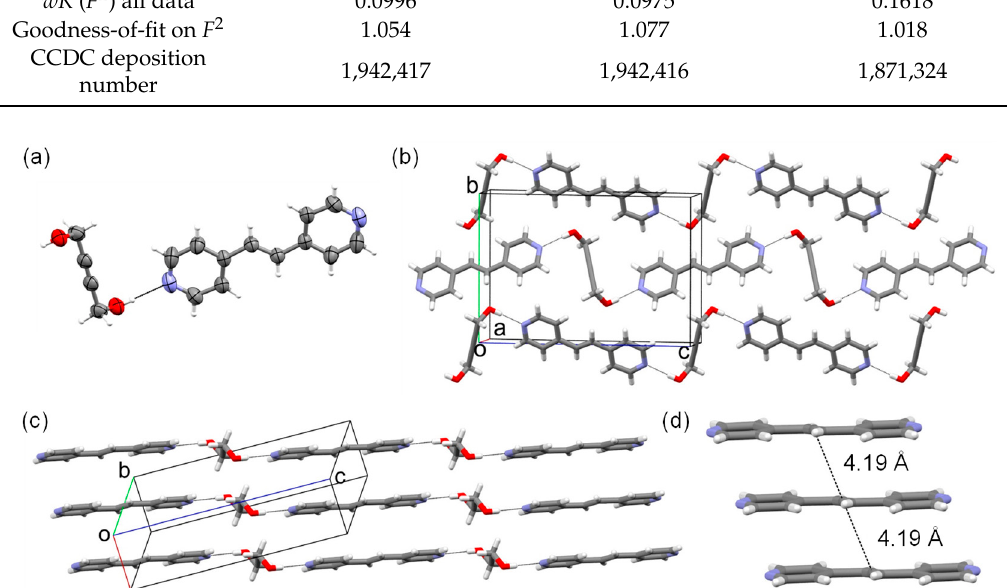
Figure 1. X-ray structure [( 1,4-bd )·( 4,4’-bpe )] n : ( a ) ORTEP representation, ( b ) 1D hydrogen-bonded chains, ( c ) stacks of hydrogen-bonded chains, ( d ) stacked C = C bonds of 4,4’-bpe .